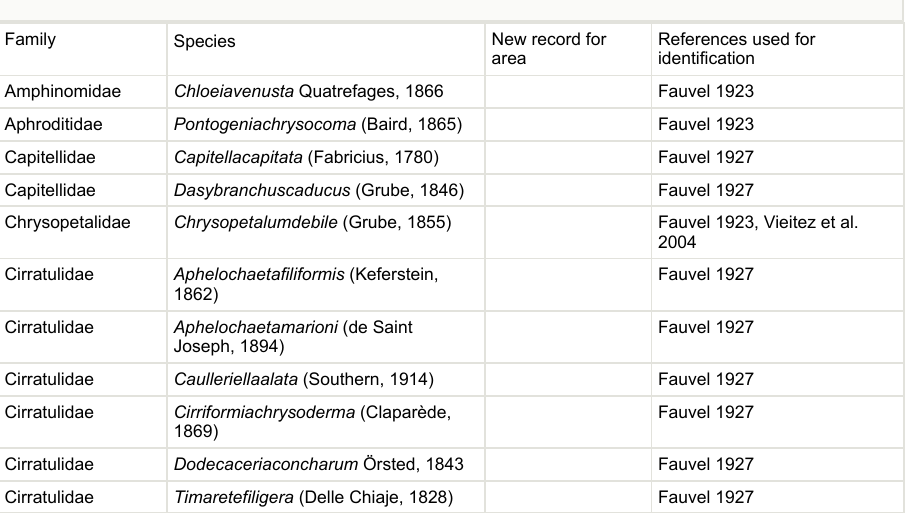
Taxa identified to species-level are included in the dataset and new records for the geographic